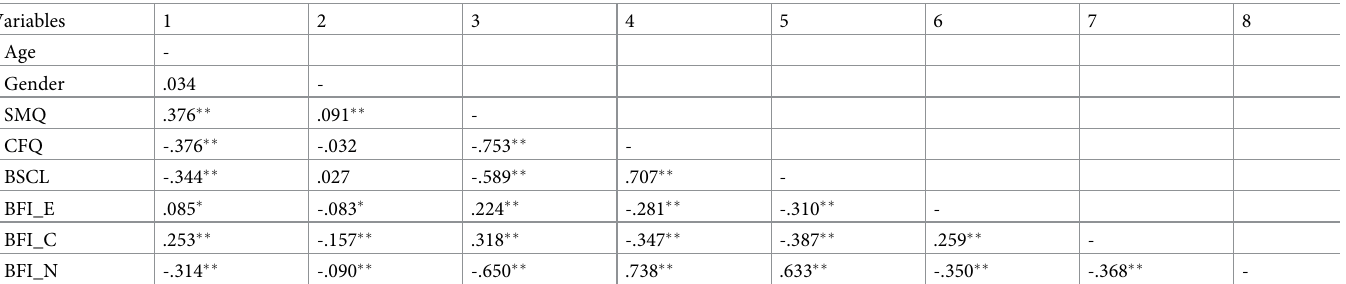
Table 3. Correlations between